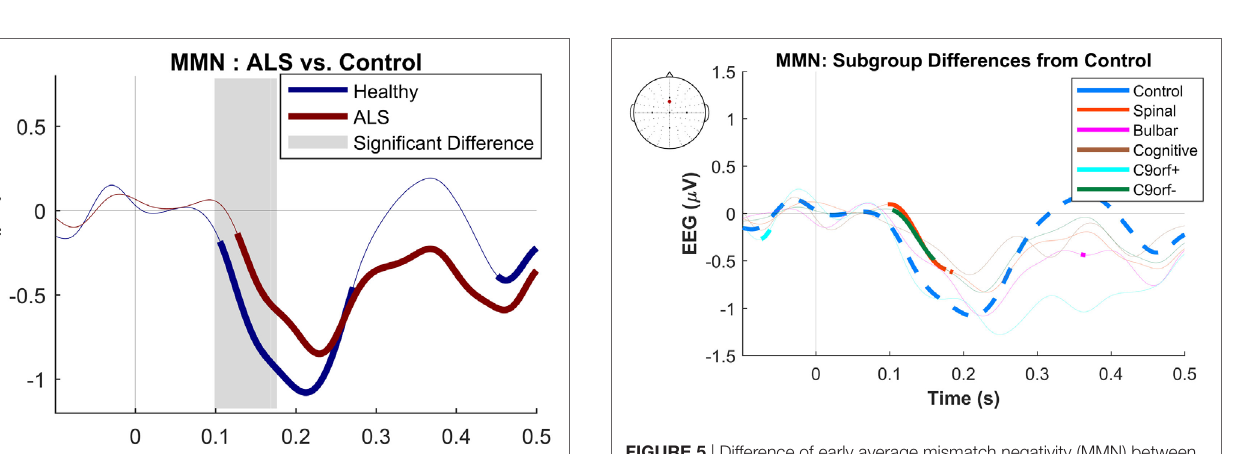
FigUre 5 | Difference of early average mismatch negativity (MMN) between controls and individual amyotrophic lateral sclerosis subgroups. The between-group differences correspond to each time-point of EEG in a frontocentral electrode located between FCz and Fz. The thick curves indicate time windows where the differences against the control waveforms are significant. See text for statistics and significance ( p < 0.05).